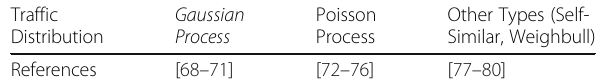
Table 9 List of Assumptions and alternative possibilities: Possible Topologies of Datacenters Topology Type